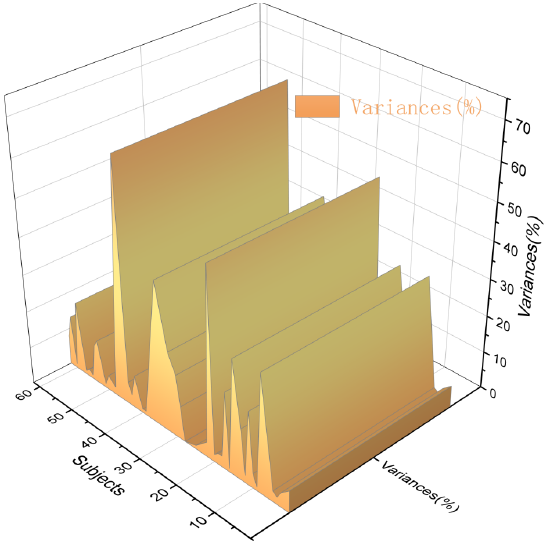
Figure 10. Trend chart of SC fluctuation variance. Source: Produced using origin 2021 software. SC fluctuation values of 64 subjects were calculated by SC variance values. In order to investigate whether the interest experience of the subjects in the digital landscape roaming scene is related to positive emotions, a correlation analysis between the five groups of interest areas and SC was conducted, as shown in Table 3. Table 3. Correlative statistics of landscape node interest degree and emotion.